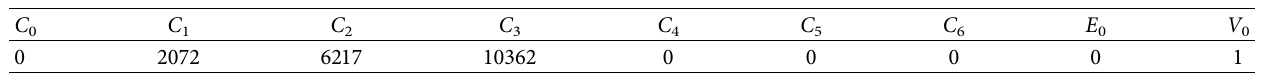
Figure 7: Stress distributing graphs of the top view and front view at 1.5ms time of impact: (a) elastic model; (b) plastic kinematic model; (c) elastic-plastic hydrodynamic model. Table 13: Eos linear